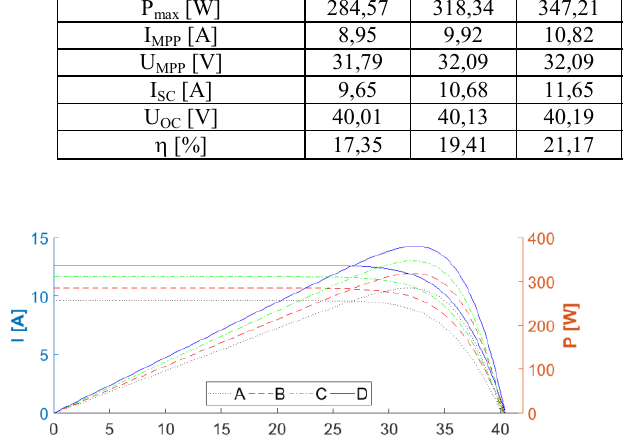
Curve on fig.2 and fig.3